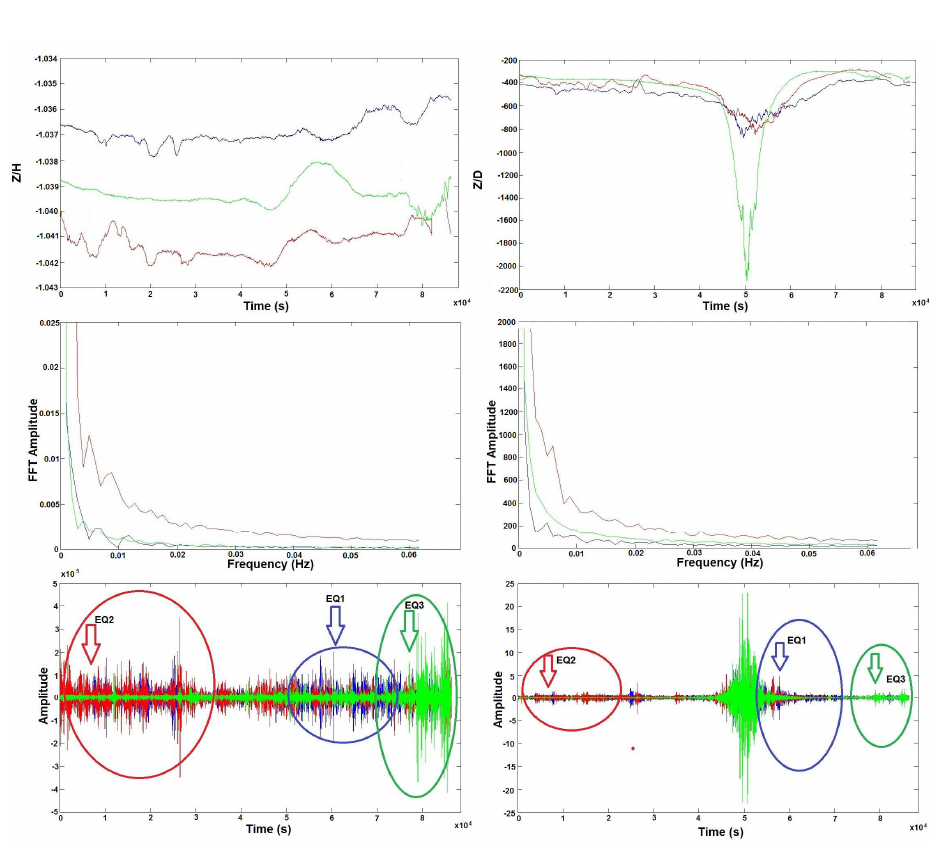
Fig. 2. Geomagnetic data analyzed: The first event is presented in blue, the second in red, and the third in green. The FFT analysis does not show important peaks. Included is a Discrete Wavelet Transform (DWT) of the Z/H and Z/D ratio in a superposed analysis in the ULF frequency range f =0.0078125 to 0.015625Hz. The main seismic shocks are shown with arrows.